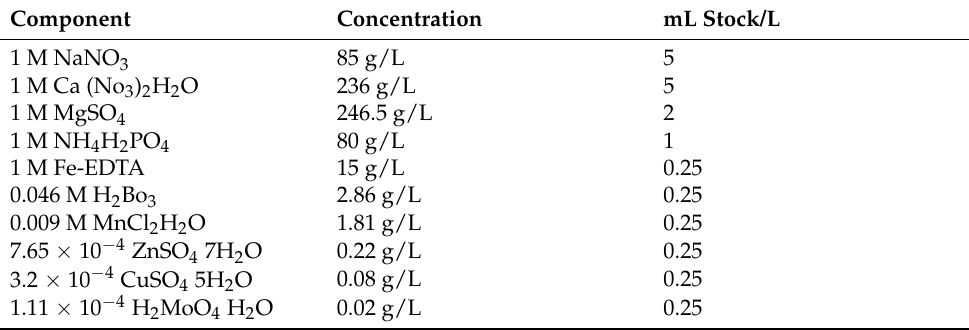
Table 1. Composition of modified Hoagland solution used in